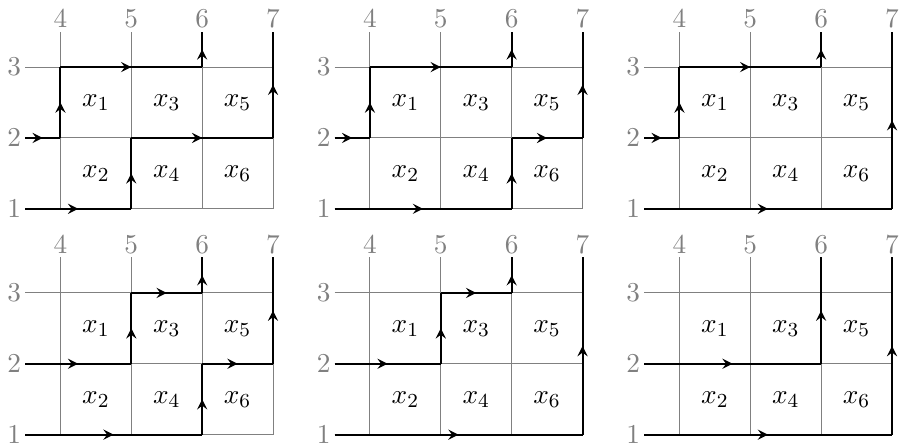
Figure 4 . Possible sets of non-intersecting paths from tion (4.1) of the Pl(cid:127)ucker coordinate p 367 in Gr(3 ; 7). consistent with the arrows which go from [ k ]